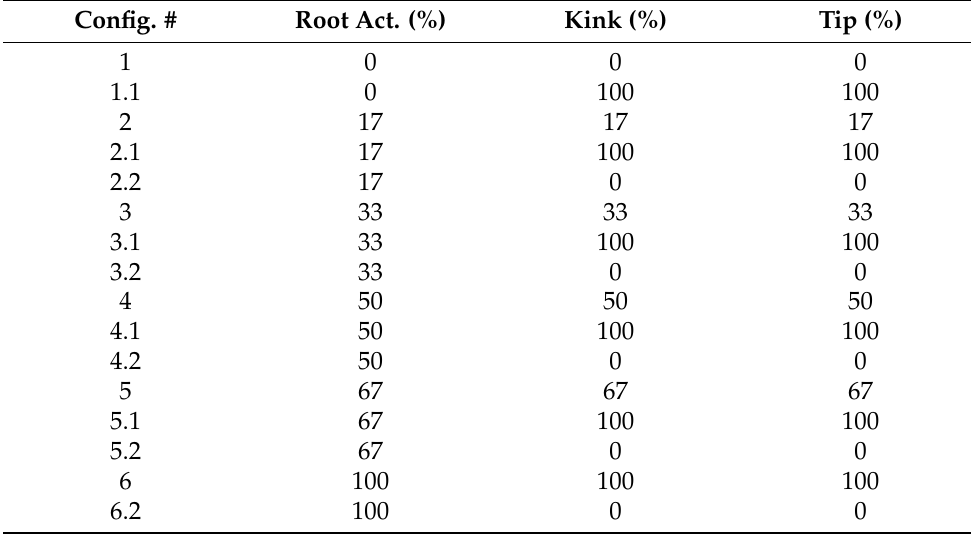
Table 1. Actuation levels for the different